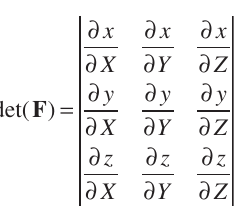
Table 1 Convergence analysis for displacements at the free end of the beam for distributed load q = 750 N/cm 2 and number of fi nite elements, m